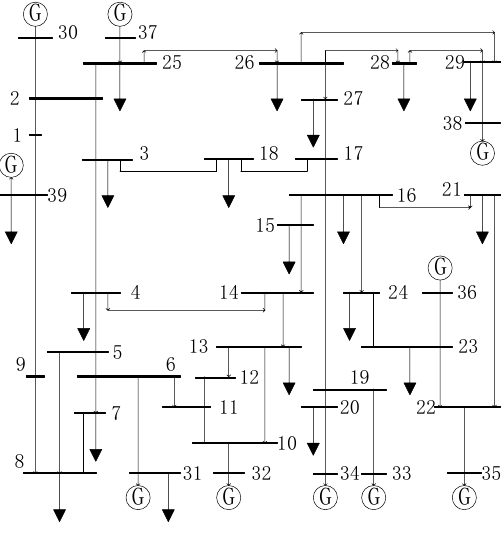
Figure 4. IEEE-39 system.